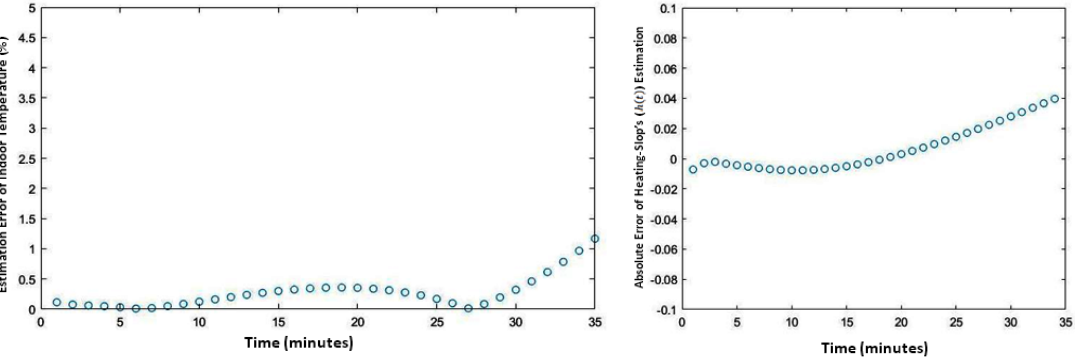
Figure 8. Indoor temperature estimation’s absolute error (left-side) and heating slop’s forecasting error (right-side).